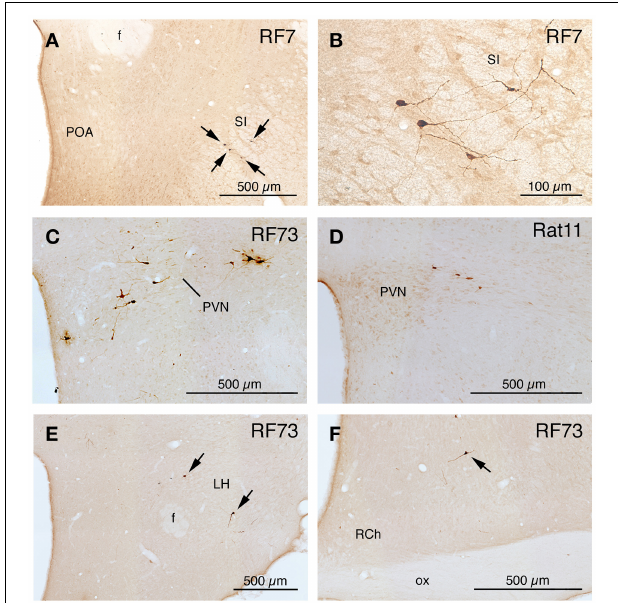
FIGURE 5 | Images of PRV-labeled neurons at rostral pons and midbrain after an intrachoroidal injection of virus into the right eye, with the labeled neurons detected by PAP immunolabeling with DAB. (A,B) Show low and high power views of PRV + neurons in the periaqueductal gray (PAG) at a rostral midbrain level. (C,D) Show low and high power views of PRV + neurons (arrows) in the lateral parabrachial nucleus (PBL) lateral to the superior cerebellar peduncle (scp), on the right side of the brain. (E) Presents a view of PRV + neurons in the left parapyramidal region (PPy) of the pons, and image (F) presents a higher power view of those PRV + neurons. All images are from RF73, which had a long survival following a minute PRV injection restricted to choroid. All images are of coronal